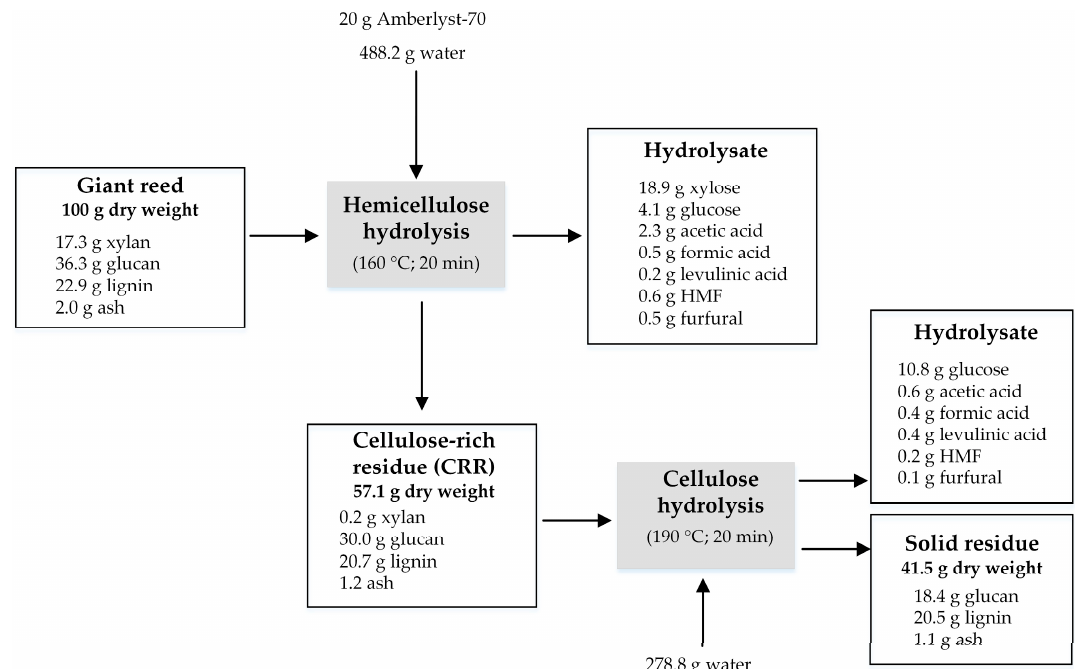
Figure 6. Mass balance flow diagram under the optimised reaction conditions for the two-step chemical hydrolysis of both raw giant reed and CRR.